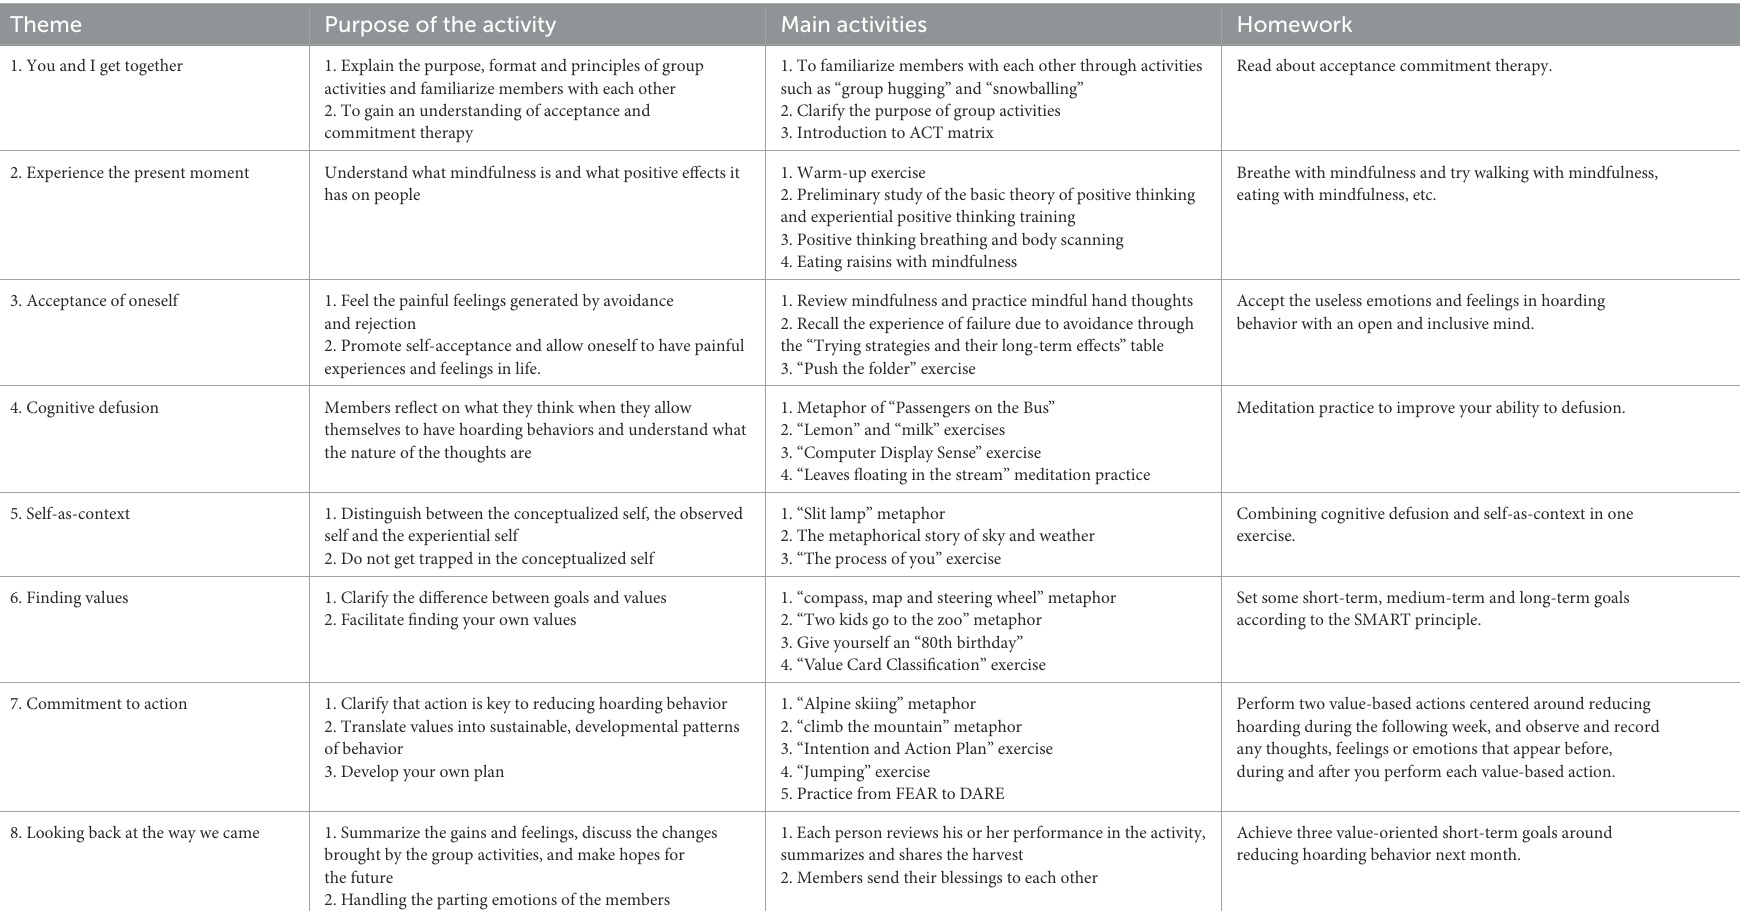
TABLE 1 Acceptance and commitment therapy intervention